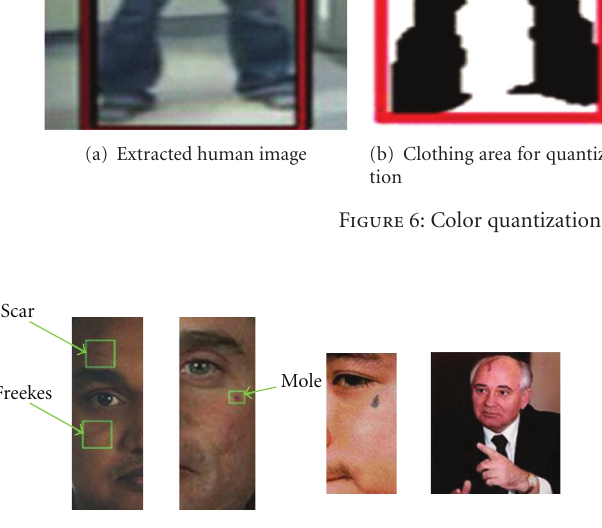
Figure 7: Examples of facial